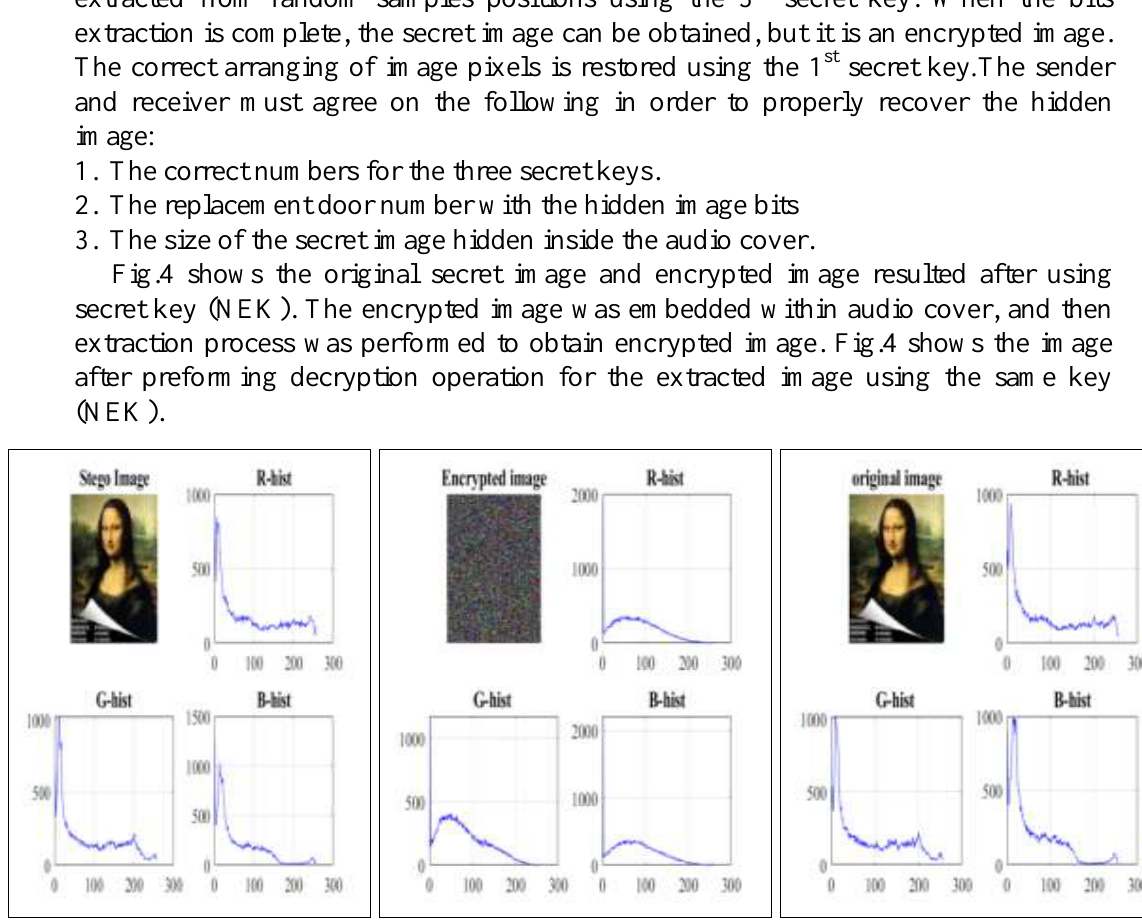
Fig.4: The original, encrypted and stego secret image to be hidden within cover